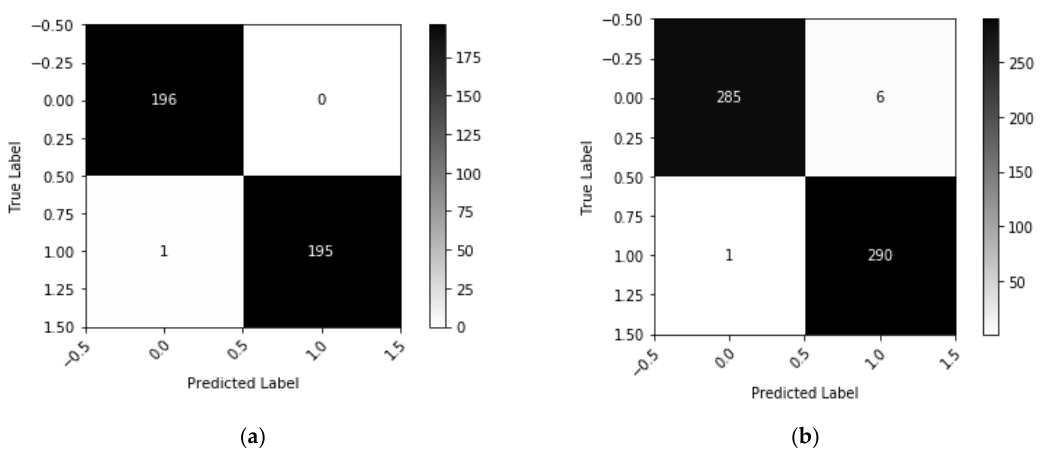
Figure A2. Confusion matrix of both experiments: ( a ) tested on manually segmented data; ( b ) tested on automatically segmented data. Table A2. Result on Cross-Validation data.